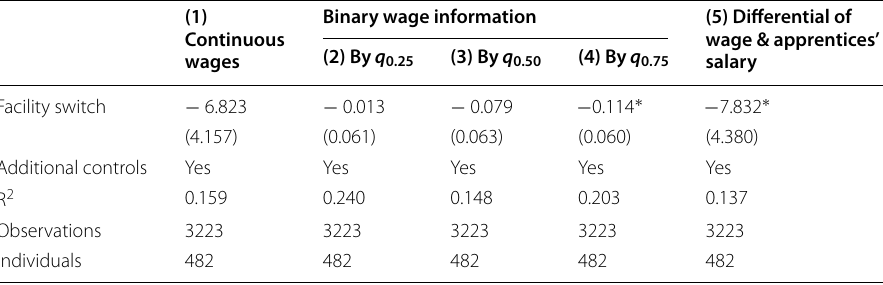
Table 5 The effect of mobility on